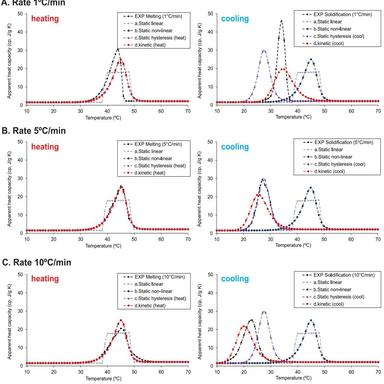
Comparison of apparent heat capacity obtained through different phase transition models at different rates.